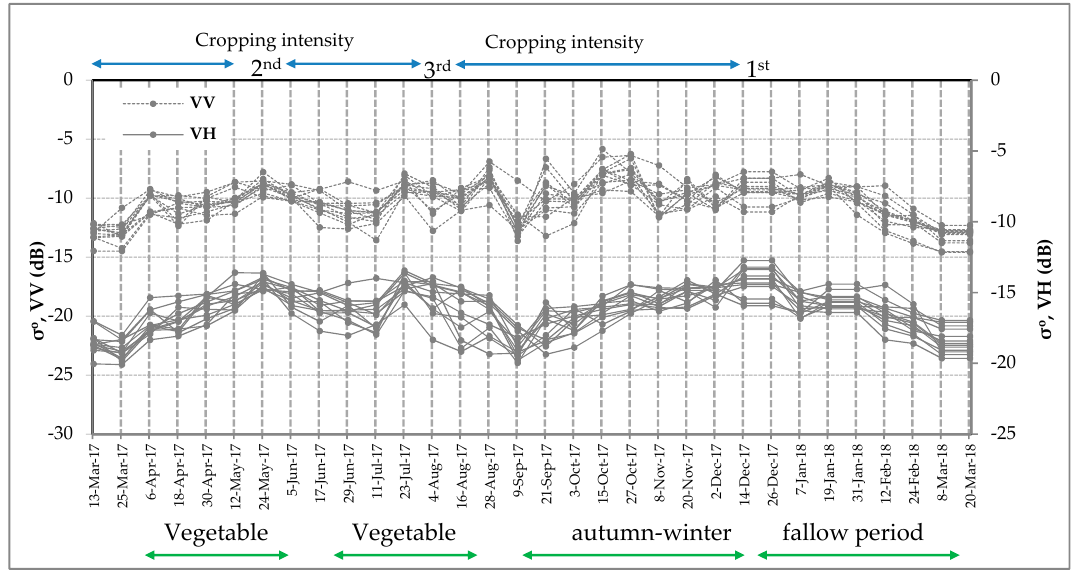
Figure 10. Graph representing the multitemporal Sentinel-1 A backscattering in the single-rice cropping area. The first vertical axis is σ o VV and the second vertical axis is σ o VH.